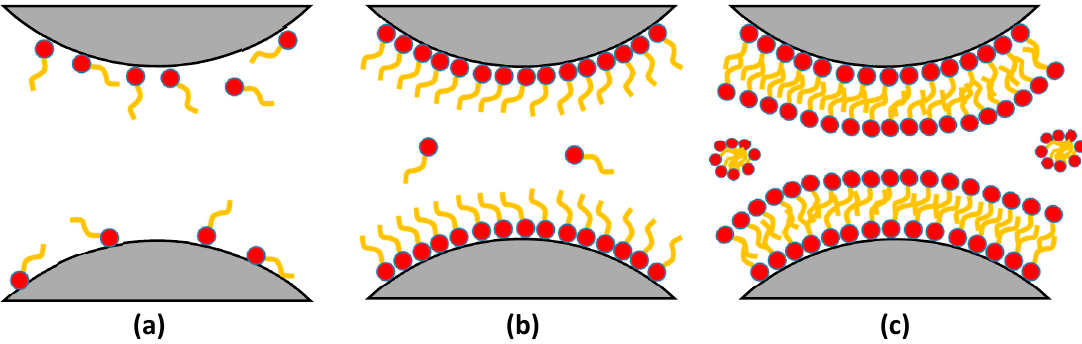
Figure 3. Schematic of fluorosurfactant adsorption on the rock surface: ( a ) low concentration; ( b ) critical micelle concentration; ( c ) high concentration. Reproduced with permission from [74], Copyright © 2002, American Chemical Society